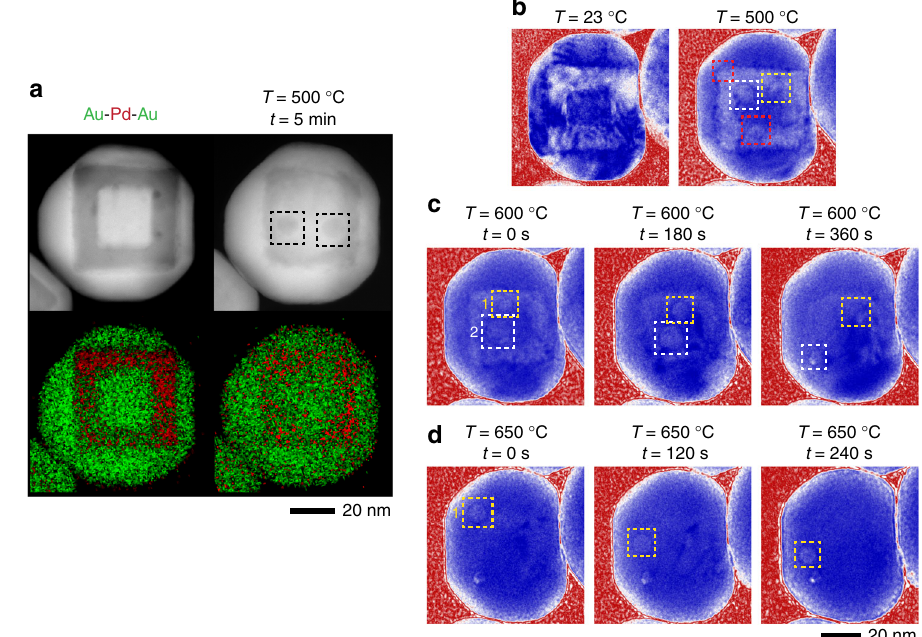
Fig. 4 Void formation and migration in Au – Pd – Au sandwich NPs at elevated temperatures. a In situ STEM (upper) and EDX (lower) images of the as-synthesized NP morphology and after heating to 500 °C. The images indicate that the voids formed in these NPs are larger than the bi-layer NPs. Voids are denoted by dashed squares. b – d In situ TEM image sequences of void migration in a Au – Pd – Au NP after heating to 500 °C, 600 °C (Supplementary Movie 4), and further to 650 °C (Supplementary Movie 5). The time-stamps in c and d are pegged to time in the supplementary movies. Note that void 1 increased in size between t = 0 s and t = 180 s at 600 °C. It can be seen from Supplementary Movie 4 that this increase was due to two void coalescence events between t = 60 – 80 s. Void 2 got annihilated at the surface between t = 180 s and t = 360 s at 600 °C (Supplementary Movie 4), resulting in a small hole on the NP surface. The sequence at 650 °C shows the extended migration of void 1 (Supplementary Movie 5). Movie 5